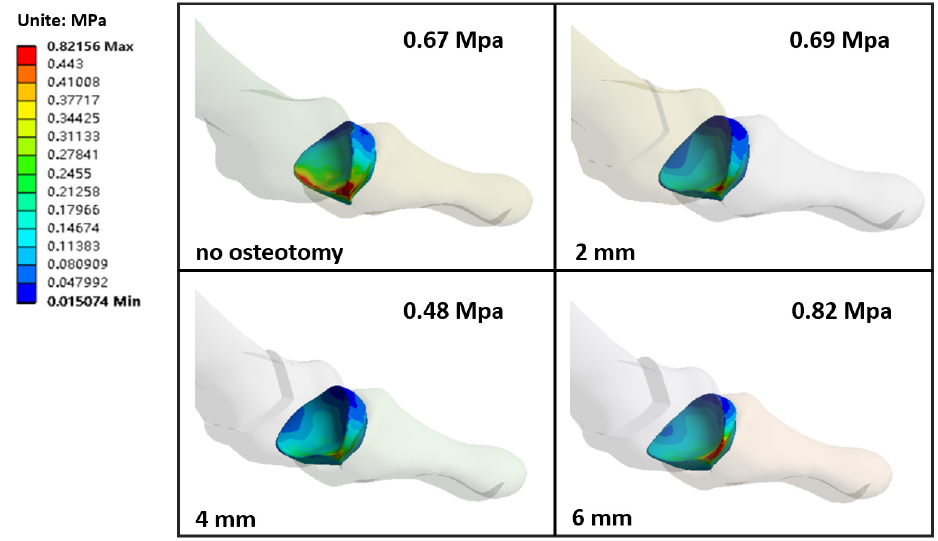
Figure 6. Stress distribution and stress value of the first metatarsophalangeal articular cartilage.